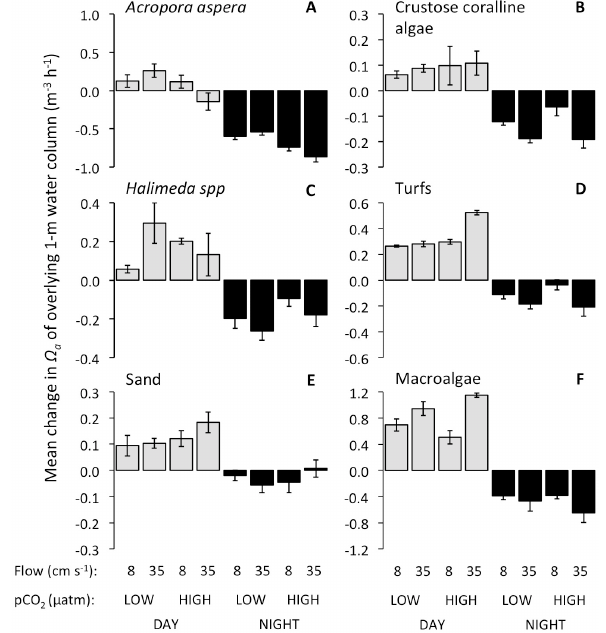
Fig. 6. Estimated hourly changes in seawater aragonite saturation state ( 1(cid:127) a /1t ) for benthic groups in a 1m deep reef flat area based on Eq. (5) and carbon flux rates in Fig. 1. Error bars are standard errors of the mean determined based on Monte Carlo analyses of data in Fig. 5 (see methods). Note different scales on y